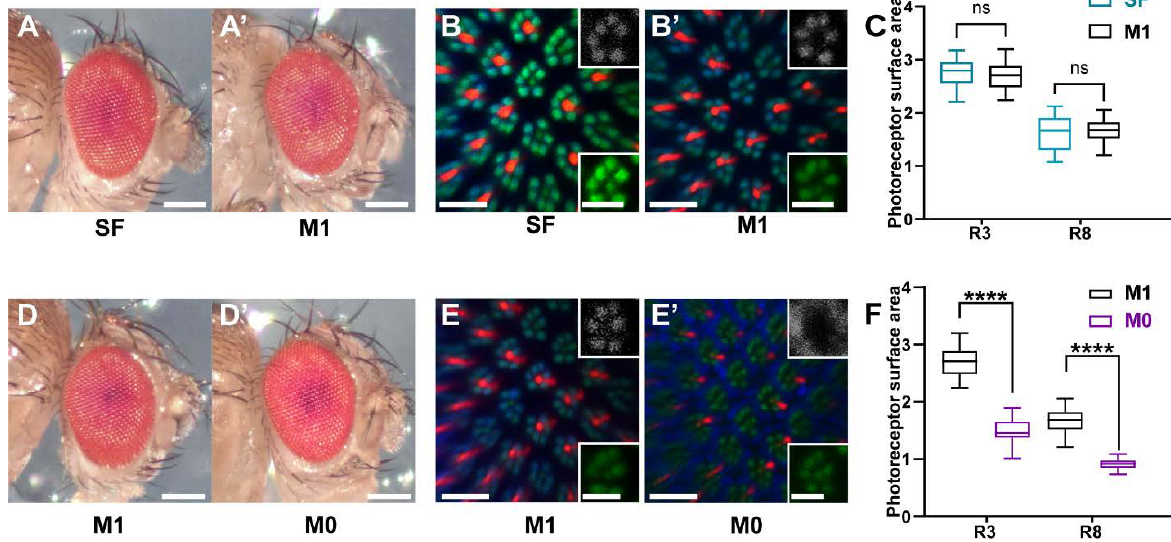
Figure 2. Eye and rhabdomere morphology of wild type Drosophila melanogaster raised on nutrient-rich ‘standard’ lab diet (SF), synthetic M1 diet containing a vitamin A precursor, or synthetic M0 diet without vitamin A precursors. ( A, A’ ) Compound eyes of wild type flies that were raised on a ‘standard’ lab diet (SF) or a minimal synthetic diet (M1). Scale bars, 250 µm. ( B, B’ ) Adult retina confocal cross-sections of wild type flies raised on SF or M1 diet. Seven F actin-rich (Phalloidin, green) rhabdomeres are visible in each unit eye (green channel); Rh1 (blue and gray channel) is expressed in the rhabdomeres of ‘outer’ photoreceptors and Rh6 (red) is expressed in the rhabdomeres of ‘inner’ photoreceptors. Scale bars, 10 µm (insets, 5 µm). ( C ) Quantification of the cross-sectional areas of the rhabdomeres (n=25 for each condition) for two photoreceptor types (R3: ‘outer’ photoreceptor; R8: ‘inner’ photoreceptor) of flies raised on SF or M1 diet. ns = not significant. ( D, D’ ) Compound eyes of wild type flies that were raised on M1 control diet or M0 diet that lacks vitamin A precursors. Scale bars, 250 µm. ( E, E’ ) Adult retina confocal cross- sections of wild type flies raised on M1 or M0 diet. Seven circular rhabdomeres (Phalloidin, green) are present in each unit eye (green channel). Rh1 (blue and gray channel) is specifically expressed in the rhabdomeres of ‘outer’ photoreceptors and Rh6 (red) is expressed in the rhabdomeres of ‘inner’ photoreceptors in the case of M1 diet. Note the reduced rhabdomere cross- sectional area (green) as well as the abnormal accumulation of Rh1 (blue and gray) and Rh6 (red) outside of the rhabdomeres in the case of M0 diet. Scale bars, 10 µm (insets, 5 µm). ( F ) Quantification of the cross-sectional areas of the rhabdomeres (n=25 for each condition) of two different photoreceptor types (R3: ‘outer’ photoreceptor; R8: ‘inner’ photoreceptor) for M1 and M0